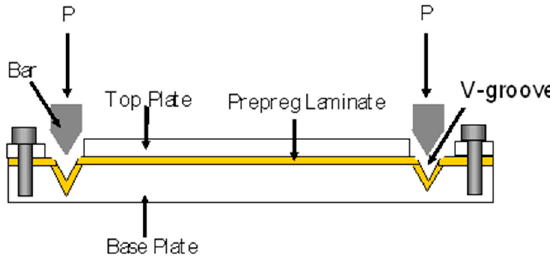
Figure 2. Schematic illustration of the V-slot mechanical pre-stressing method used by Schulte and Marissen [35].